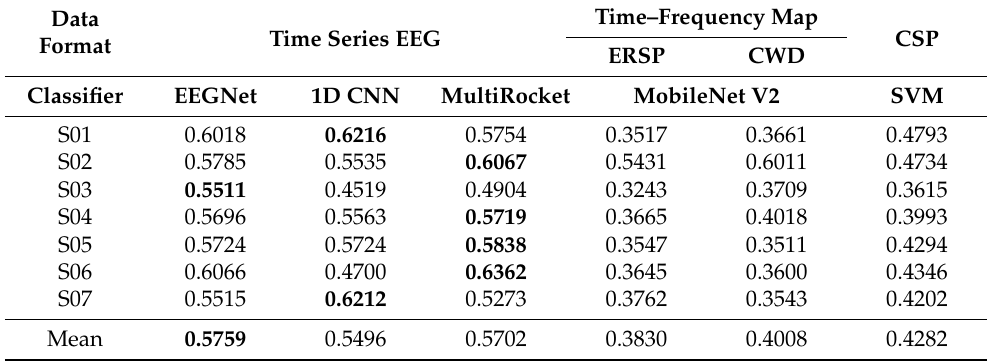
Table 3. Each subject’s classification accuracy of 3-category VP according to the data type and classifiers.